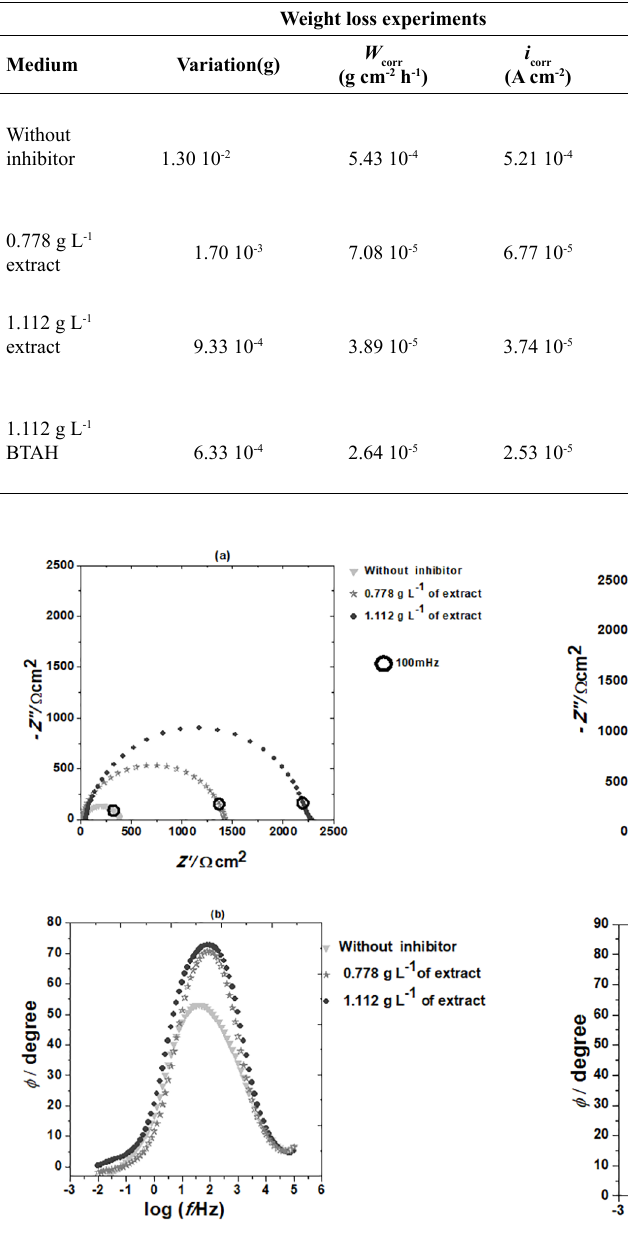
Table 1. Weight loss of CS – ASTM 1020 after 120 min immersion in 18.23 g L -1 HCl solution in the absence and in the presence of inhibitors